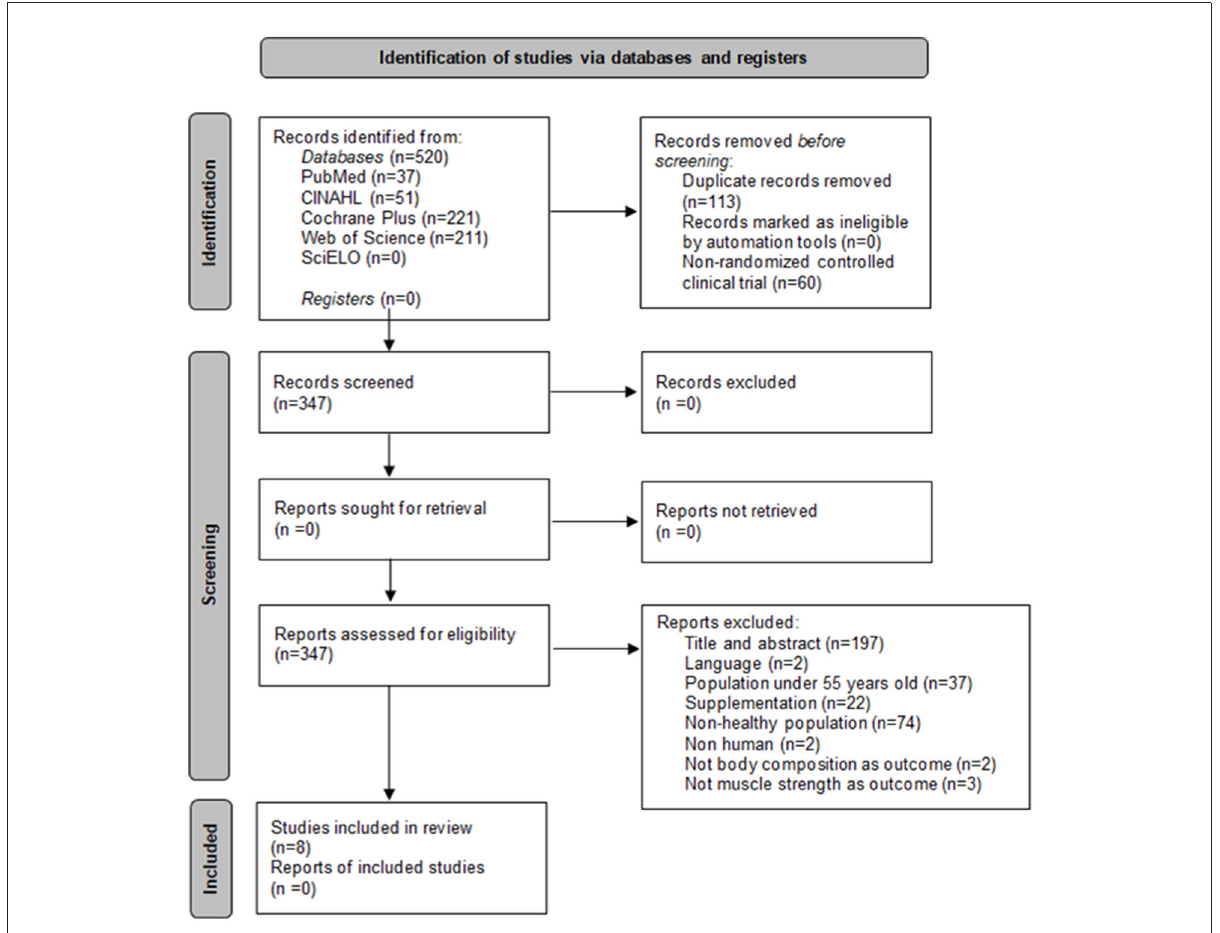
FIGURE1 PRISMA flowchart showing the inclusion and exclusion of studies in the systematic